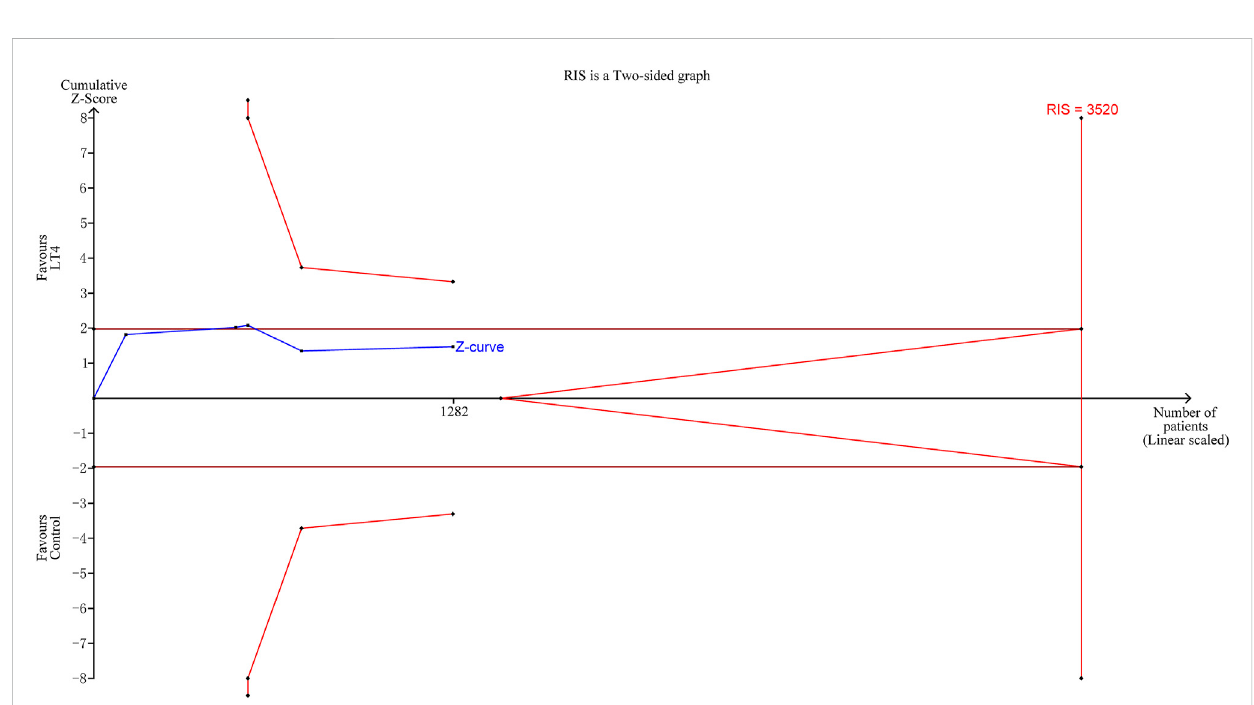
FIGURE 3 Trial sequential analysis of preterm birth. The risk of type I error was set at 5% with a power of 80%. The relative risk reduction (RRR) was set at 20%. The variance was calculated from the data obtained from the included trials.